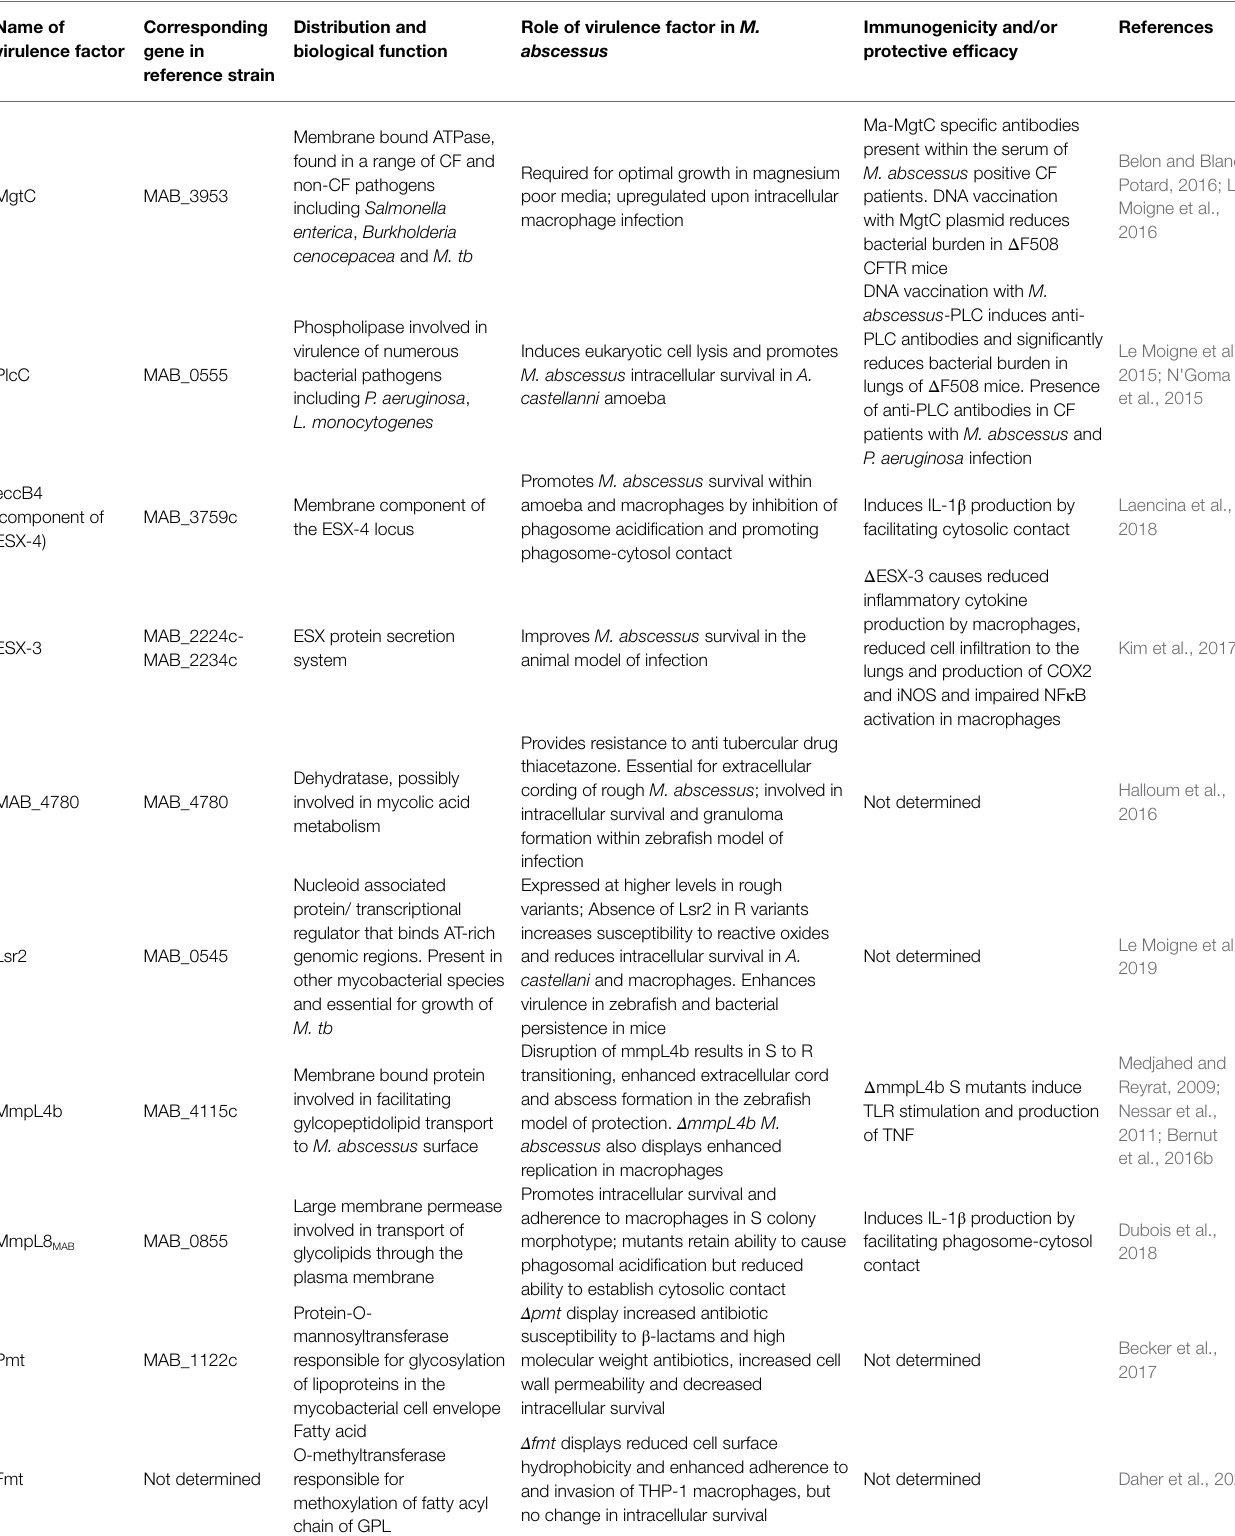
TABLE 1 | Known virulence factors of Mycobacterium abscessus. Name of Corresponding virulence factor gene